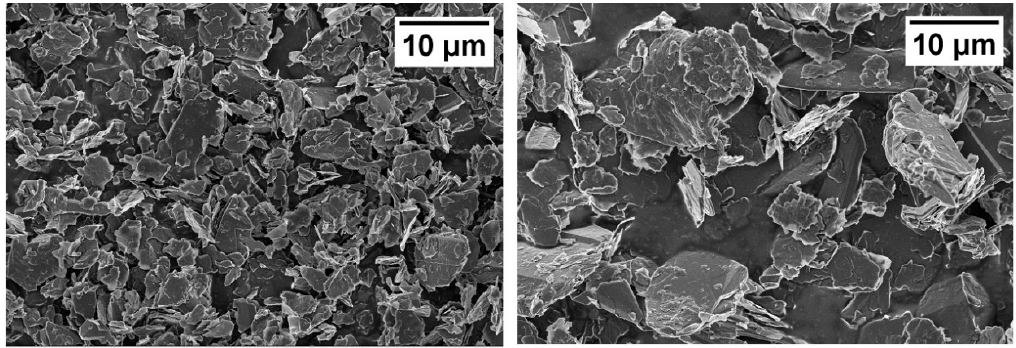
Figure 4. Records from scanning electron microscope of small (3.6 μ m) and large (18.4 μ m) graphitic particles.